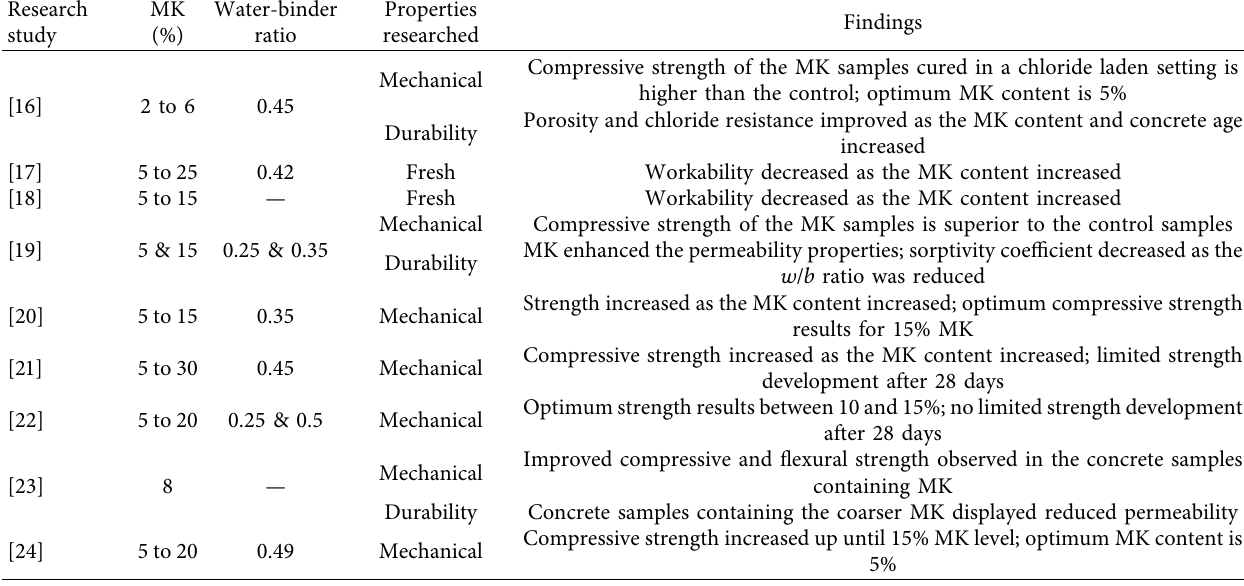
Table 1: Previous studies on the engineering properties of concrete containing varying amounts of metakaolin (MK).